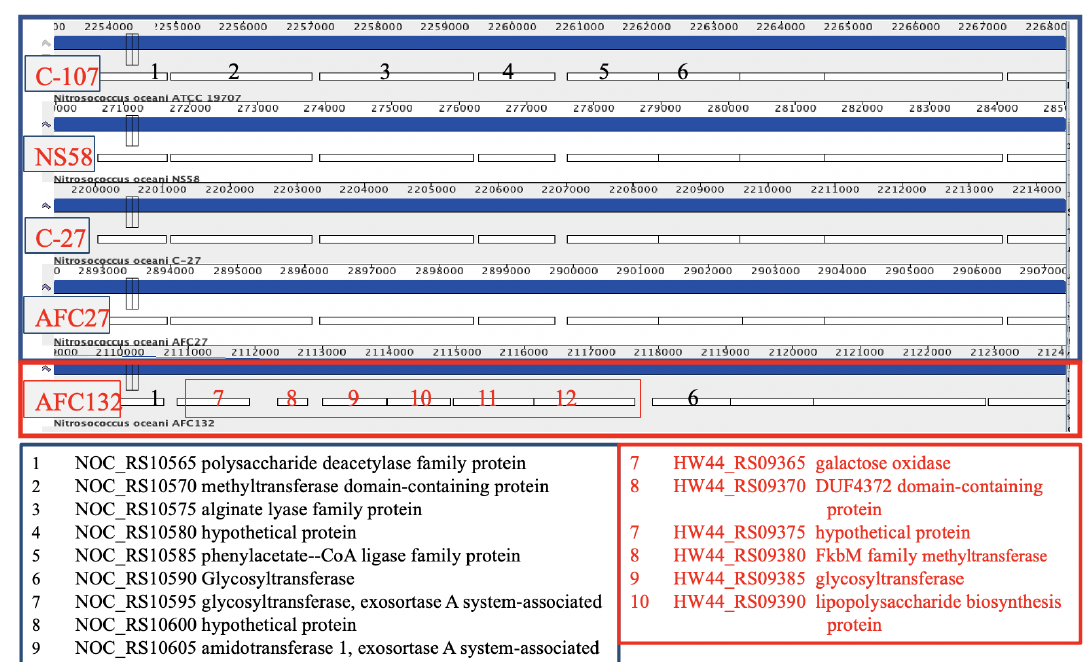
Figure 6. Differences between polysaccharide synthesis and glycosyl transferase encoding clusters at homologous positions in genomes of strains C-107, NS58, C-27, and AFC27 compared with strain AFC132.